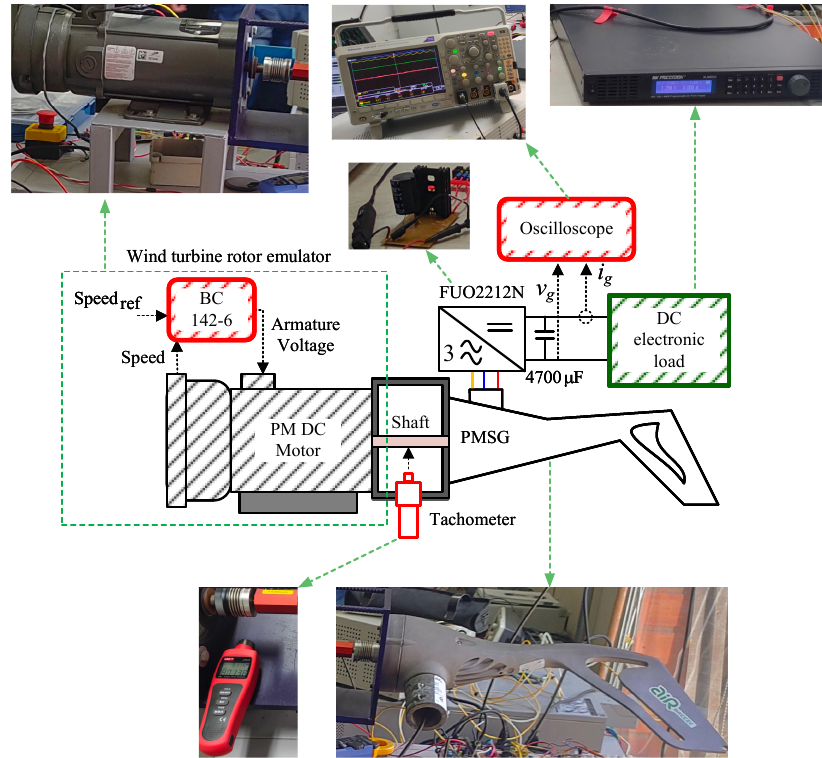
Figure 1. Scheme for the characterization of the